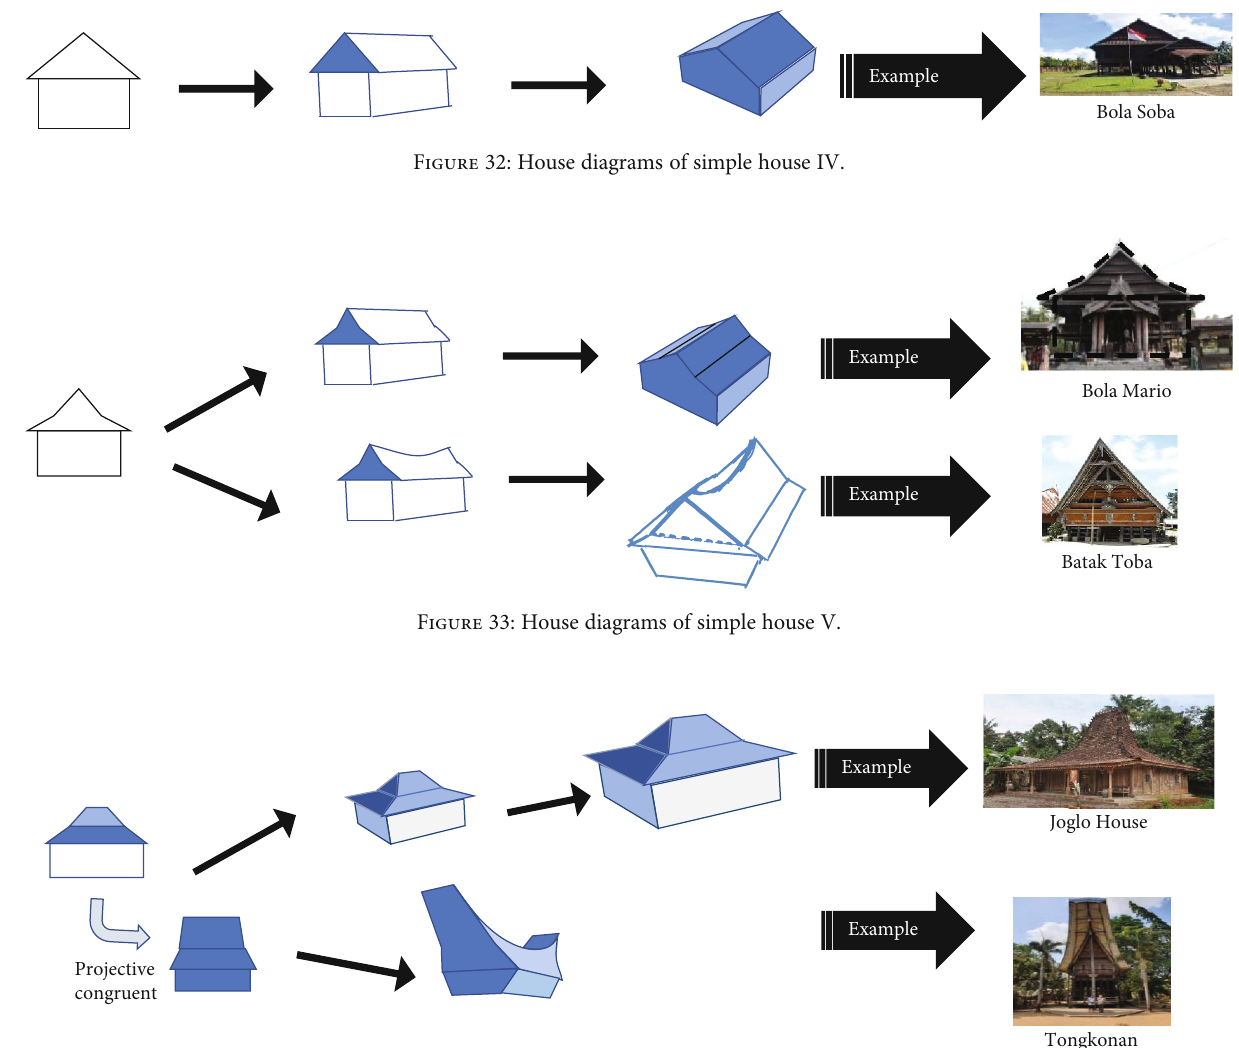
Figure 34: House diagrams of simple house